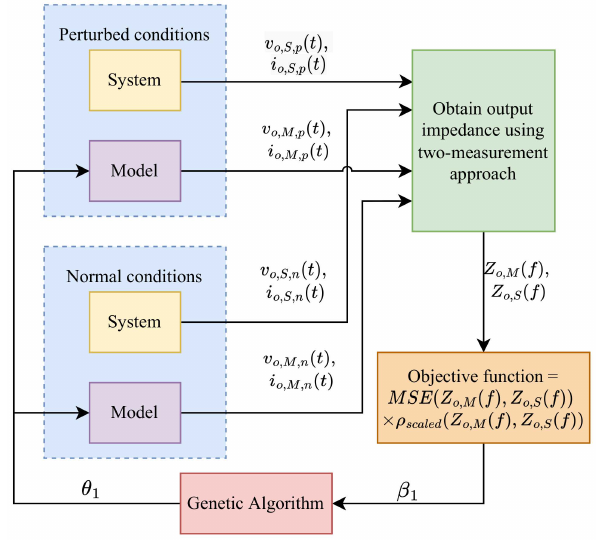
Figure 7. Block diagram illustrating the parameter estimation methodology used during step 1.